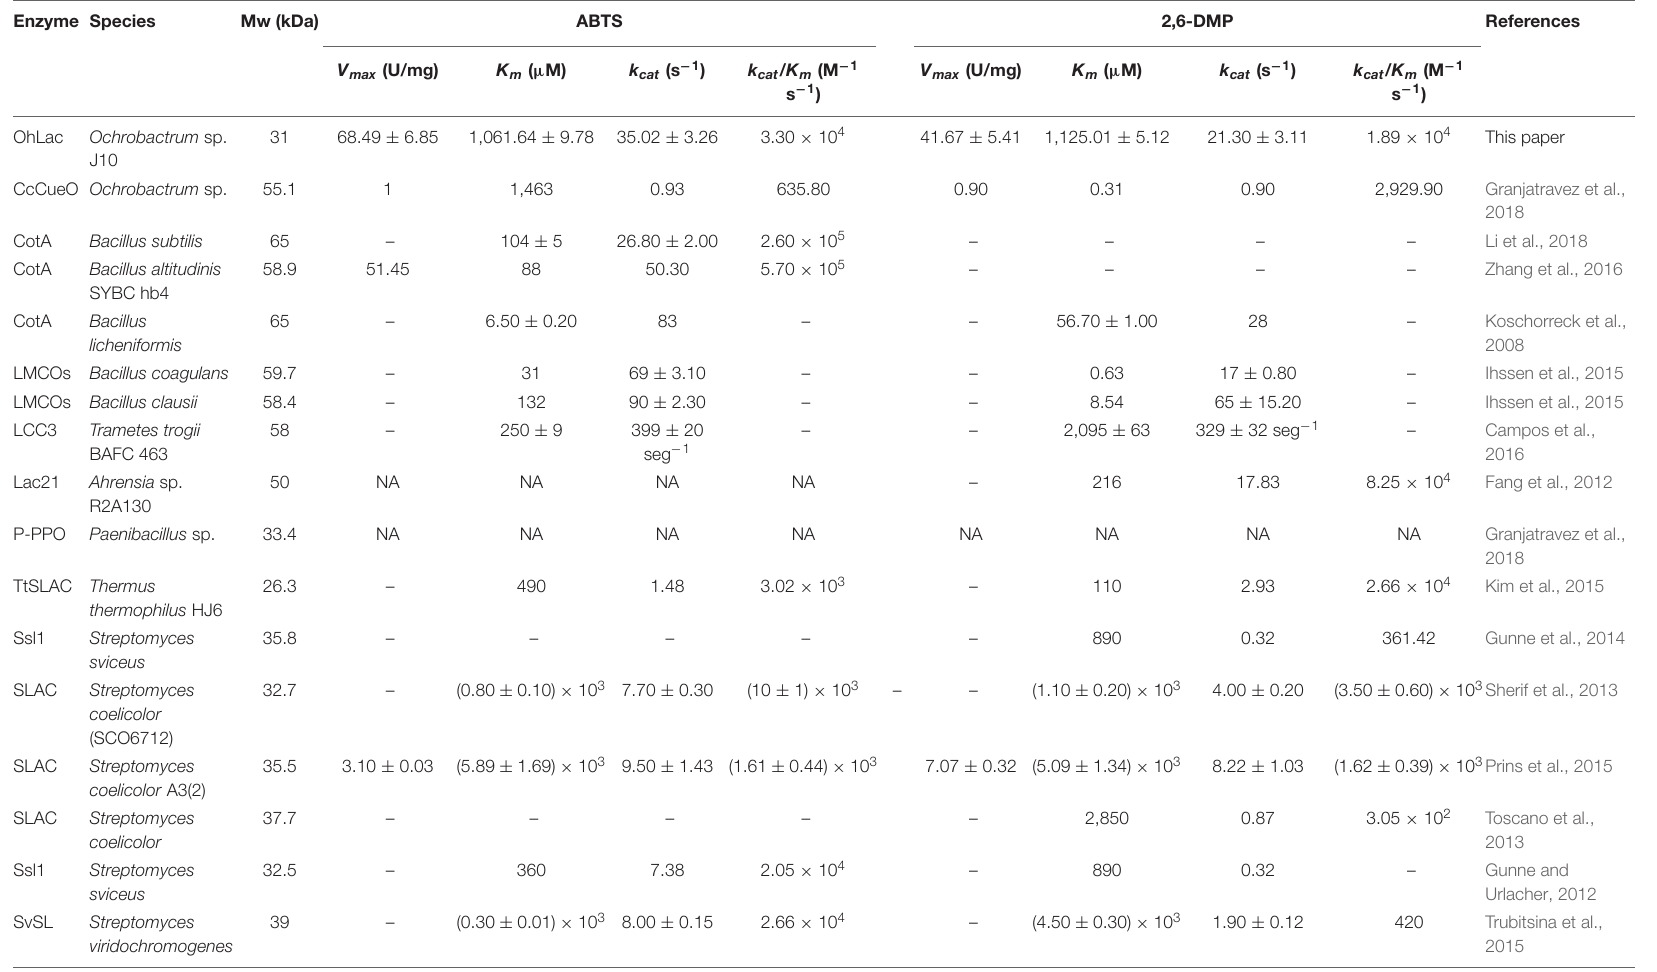
TABLE 2 | The review of steady-state kinetic parameters of multi-copper polyphenol oxidoreductases. Enzyme Species Mw (kDa) ABTS